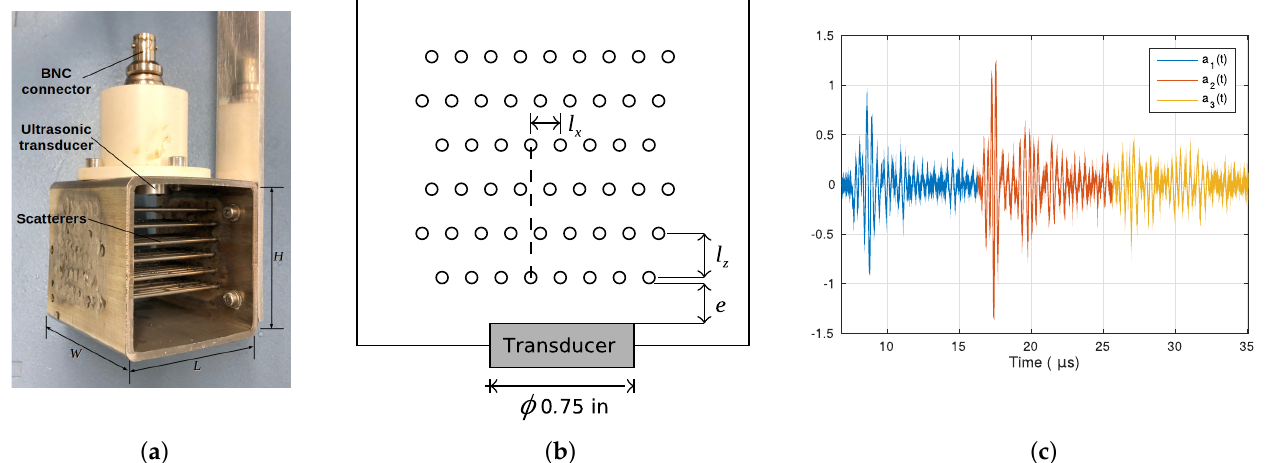
Figure 1. Multiple-scattering sensor: ( a ) image, ( b ) schematic representation of the distribution of the cylindrical scatterers in front of the transducer, and ( c ) acquired backscattering signal in